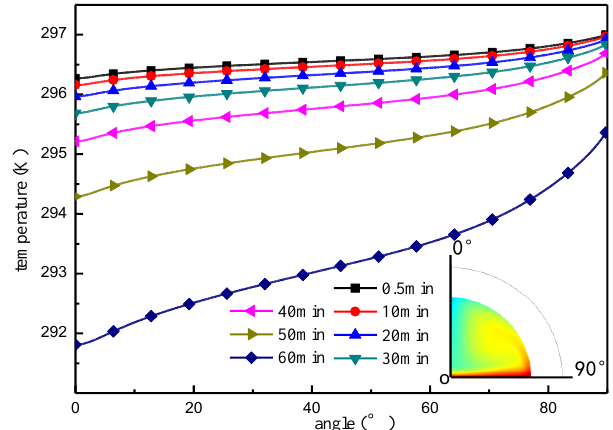
Figure 8. Droplet surface temperature distribution.